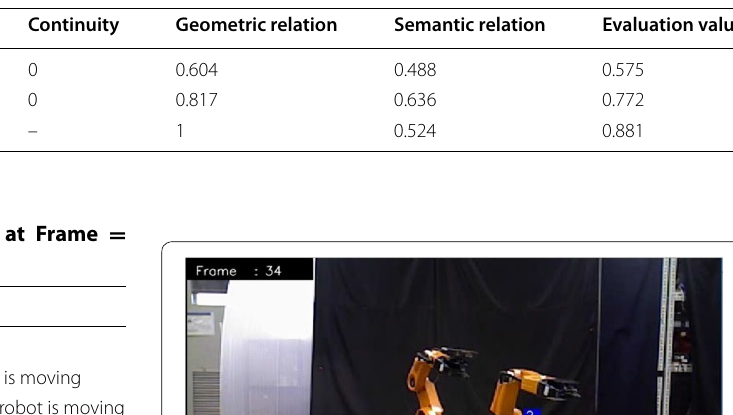
Table 8 Each evaluation value at Frame = 512